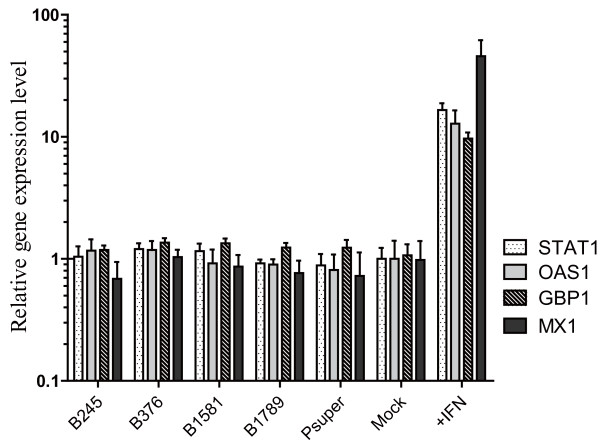
The expression profile of four major interferon stimulated genes (ISGs) in shRNA plasmids transfected cells. Cytoplasmic RNAs, from Huh7 cells treated with or without IFNα-2a or transfected with either pSUPER vector or shRNA plasmids, were analysed by realtime RT-PCR for IFN stimulated genes STAT1, OAS1, GBP1 and MX1. The values on the figure, plotted as "Relative gene expression level" on the y-axis, were calculated as the mRNA levels of ISGs divided by the GAPDH (control) mRNA level. Student t test was used to assess the difference between shRNA plasmids (including empty pSUPER vector) of transfected cells and non-transfected cells (mock). No significant difference was observed.